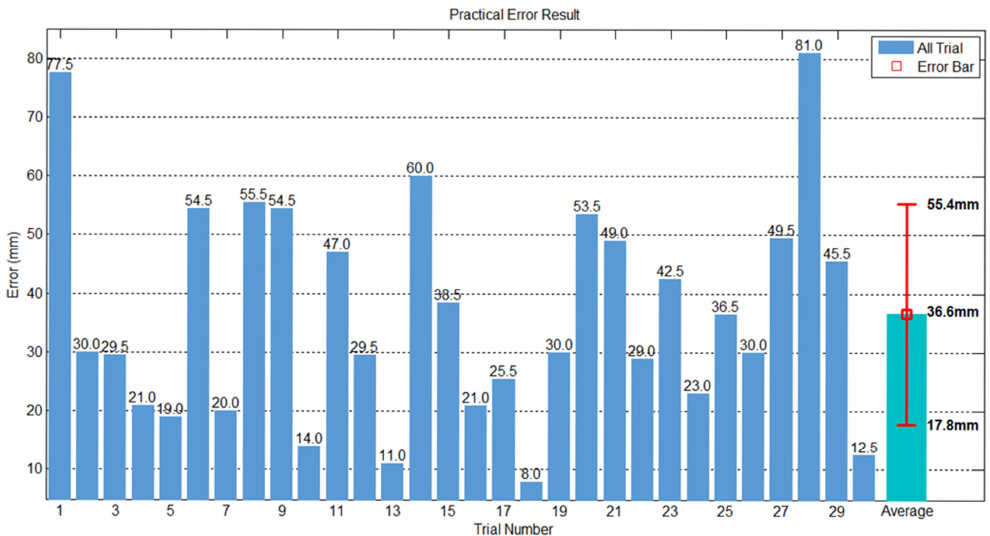
Figure 22. Overall striking